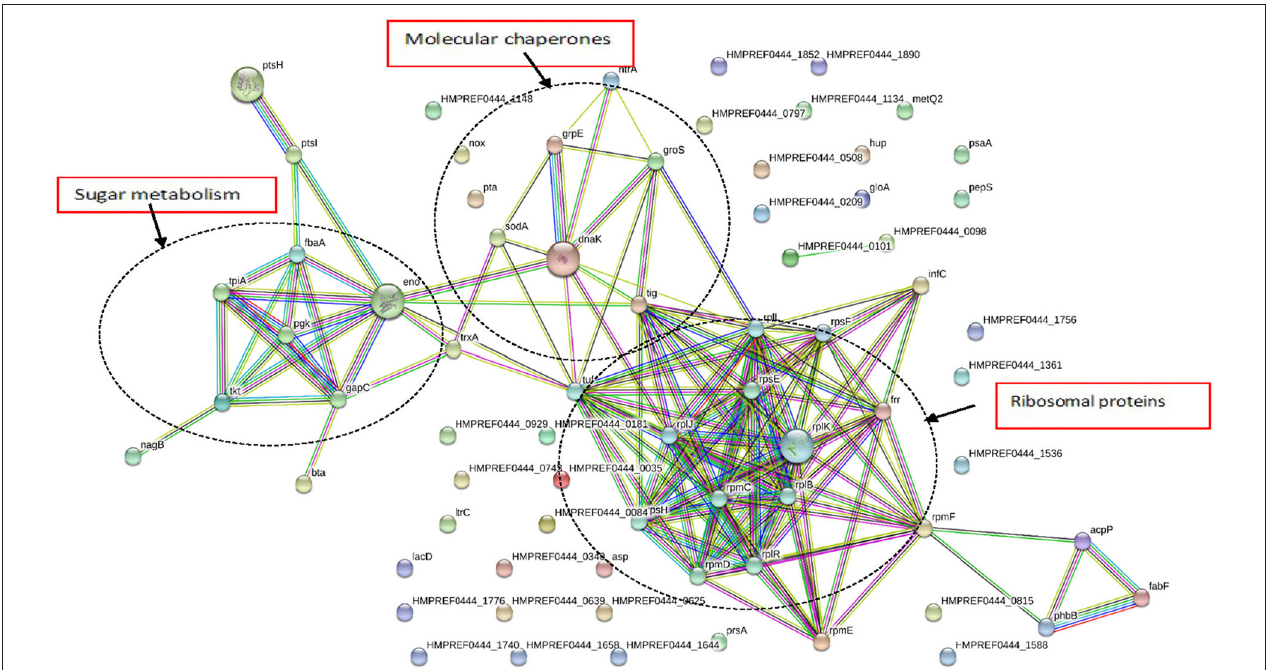
FIGURE 4 | Functional protein association networks of G. adiacens secretome. The online tool STRING was used for grouping the secreted proteins on the basis of functional networks. Minimum interaction scores were set at a strong confidence level of 0.7. The three major network groups formed are shown in dotted circles. Seven different colored link a number of nodes and represent seven types of evidence used in predicting associations. A red line indicates the presence of fusion evidence; a green line represents neighborhood evidence, a blue line represents co-occurrence evidence; a purple line represents experimental evidence; a yellow line represents textmining evidence; a light blue line represents database evidence and a black line represents coexpression evidence.